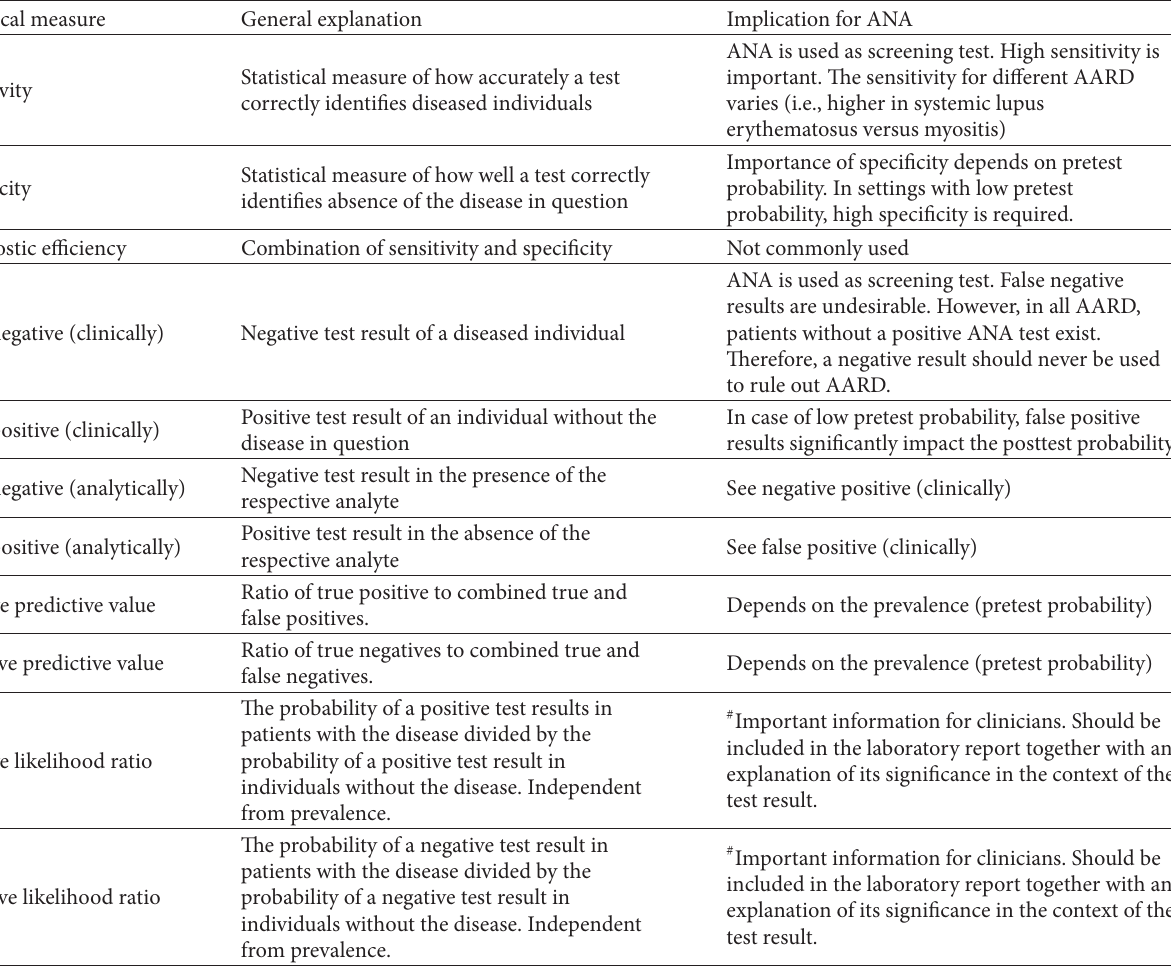
Table 1: Statistical terms relevant for ANA